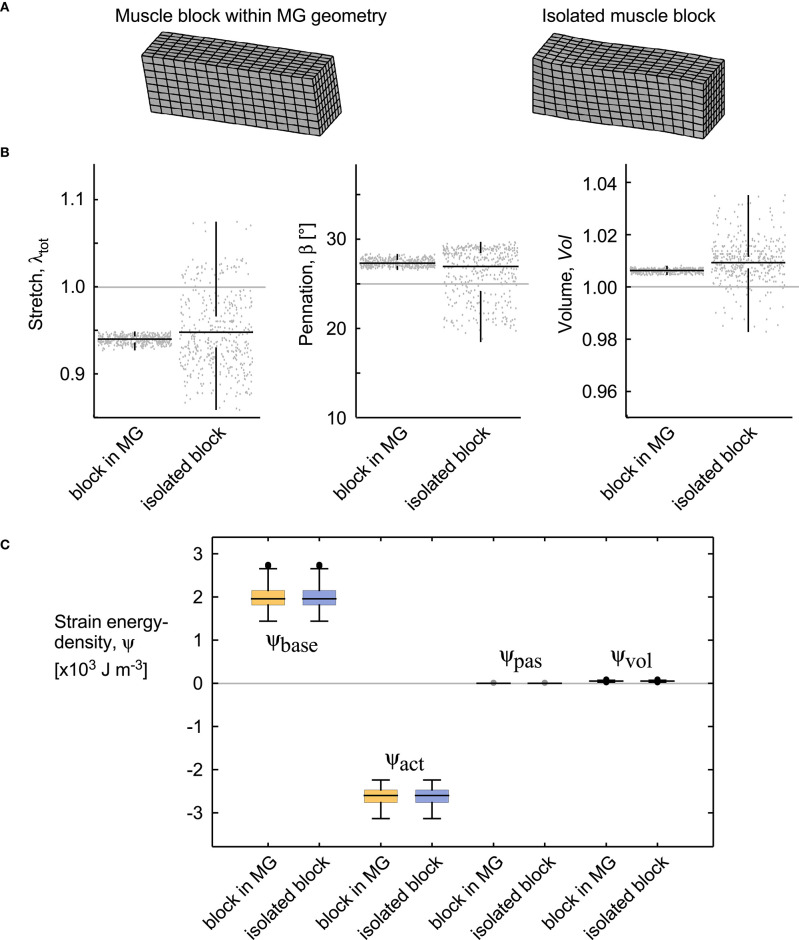
Deformations and energies for a block of muscle within the medial gastrocnemius and an isolated block. Both simulations were evaluated for β0 = 25° and 20% activation (similar to the extreme conditions in Figures 10, 12). (A) Geometries of the muscle blocks. (B) Stretch, pennation angle, and volume shown for each quadrature point, the median for these values (horizontal black bar), and the spread of the data (vertical black bar). (C) Strain energy-densities for these blocks. The boxes show the 25 and 75% quantiles, with the median value indicated in the middle. The grey bars show the values for the undeformed state V0.